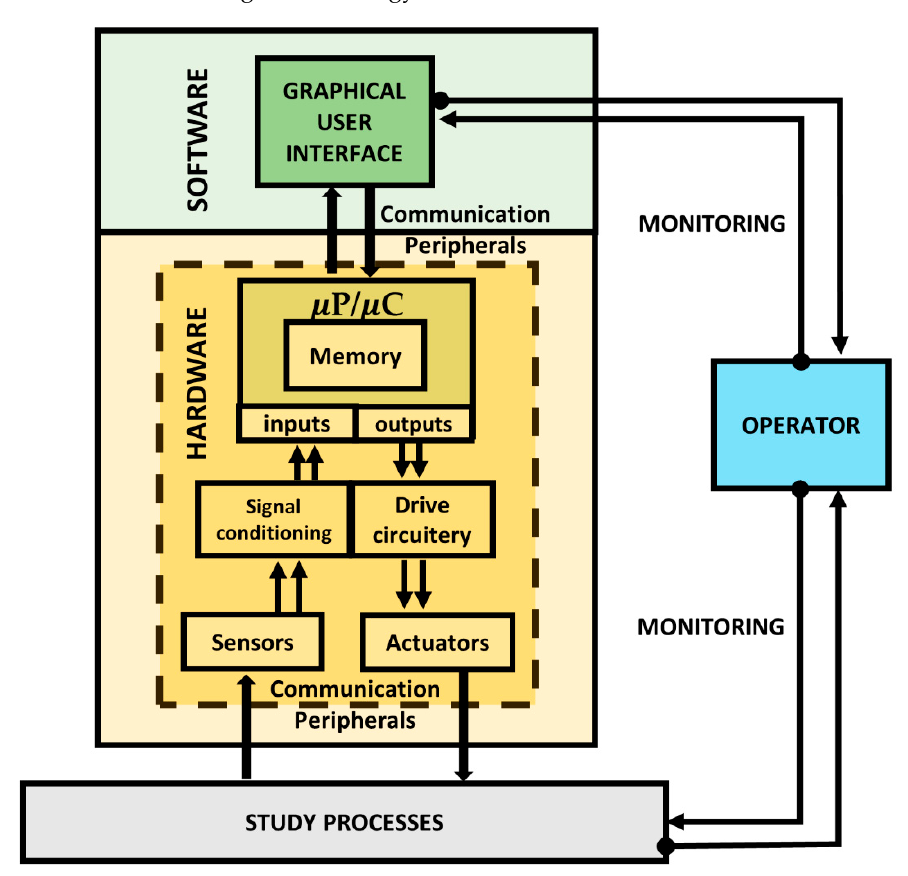
Figure 2. G eneral architecture of an ES. Figure 2. General architecture of an